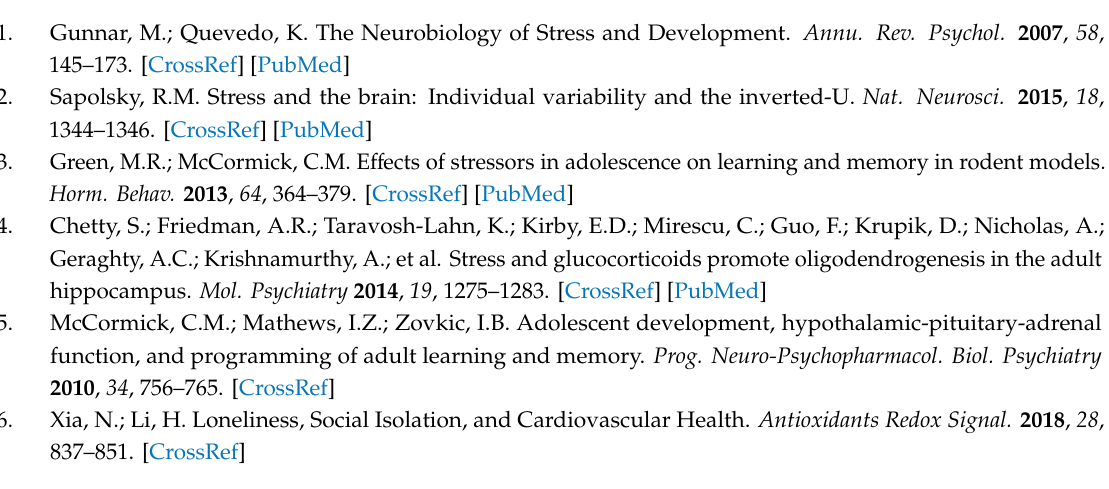
in Figure 7F. Table S12: The latency to enter the dark compartment of the arena in the passive avoidance paradigm (mean ± SEM). The results of post hoc analysis are shown in Figure